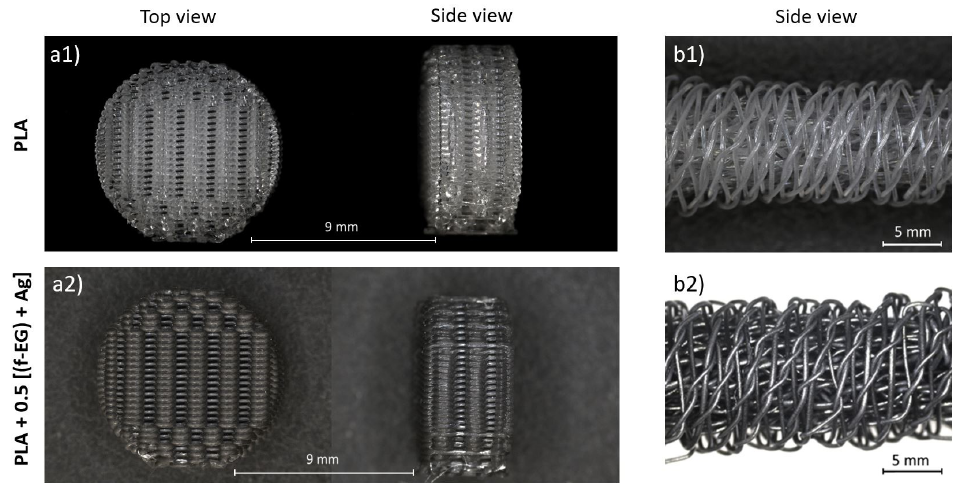
Figure 17. Stereoscopic magnifying glass images of PLA scaffolds obtained by ( a1 ) 3D printing and ( b1 ) textile engineering and of PLA+0.5[(f-EG)+Ag] scaffolds obtained by ( a2 ) 3D printing and ( b2 ) textile engineering.